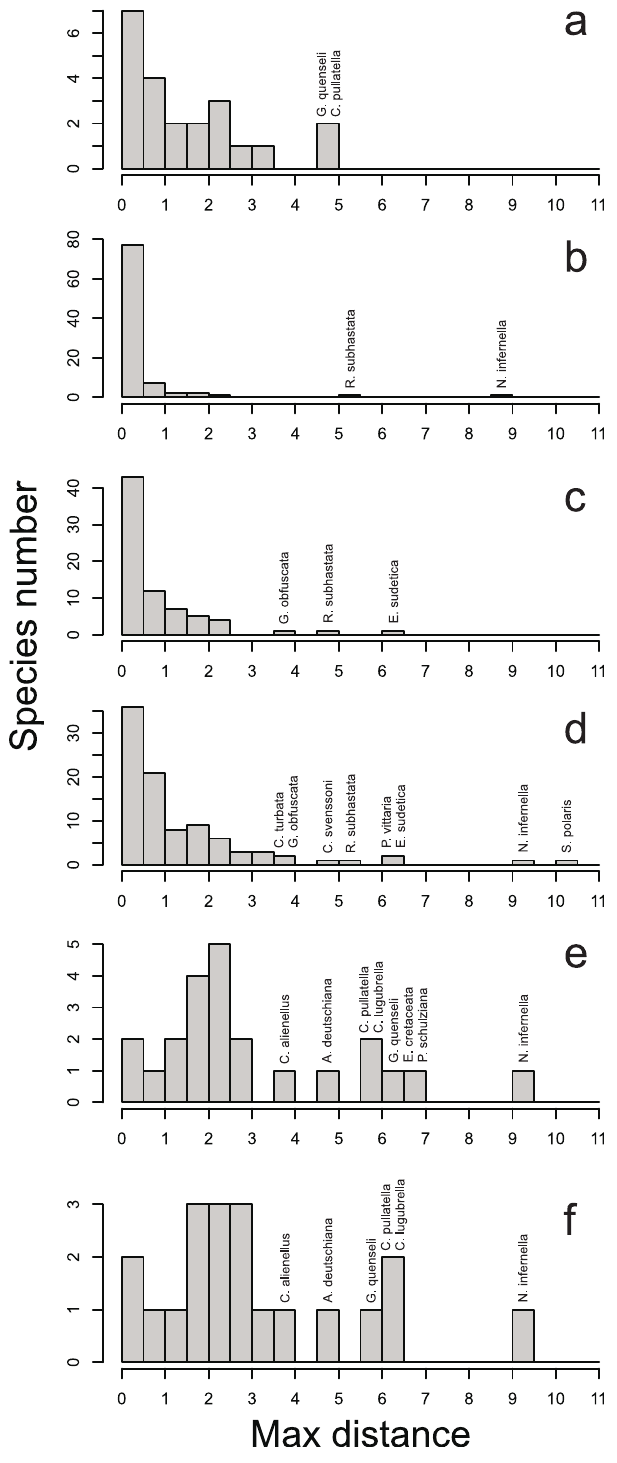
Figure 2. Distributions of maximum intraspecific barcode divergences (MAX) within and between the study regions. The x-axis shows MAX values in percentage. 2A. within North America, 2B. within Fennoscandia, 2C. within Alps, 2D. between Alps and Fennoscandia, 2E. between Alps and North America, 2F. between Fennoscandia and North America. Species showing over 4% intraspe- cific divergence are indicated above the bars.